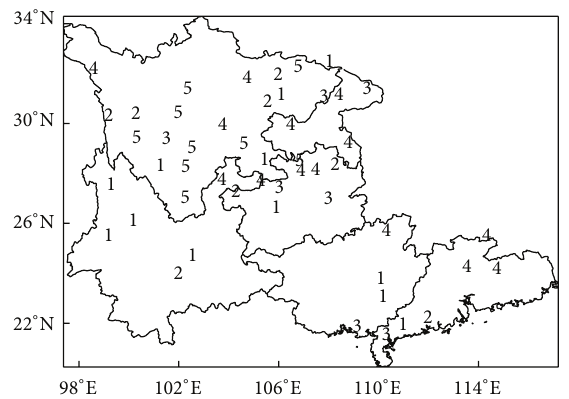
Figure 5: Cumulative months of negative precipitation accumula- tion: June–August 2006.